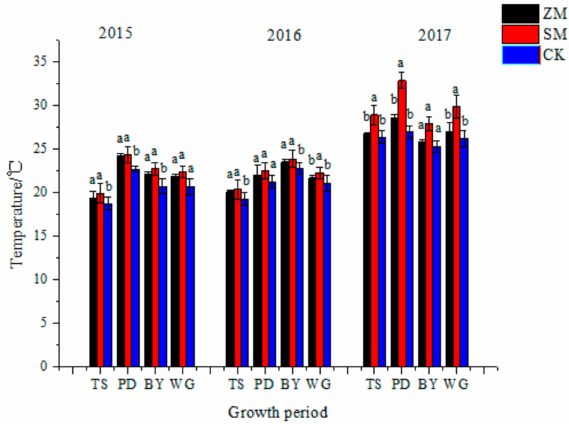
Figure 4. Changes of soil temperature in 0.05 m depth under di ff erent